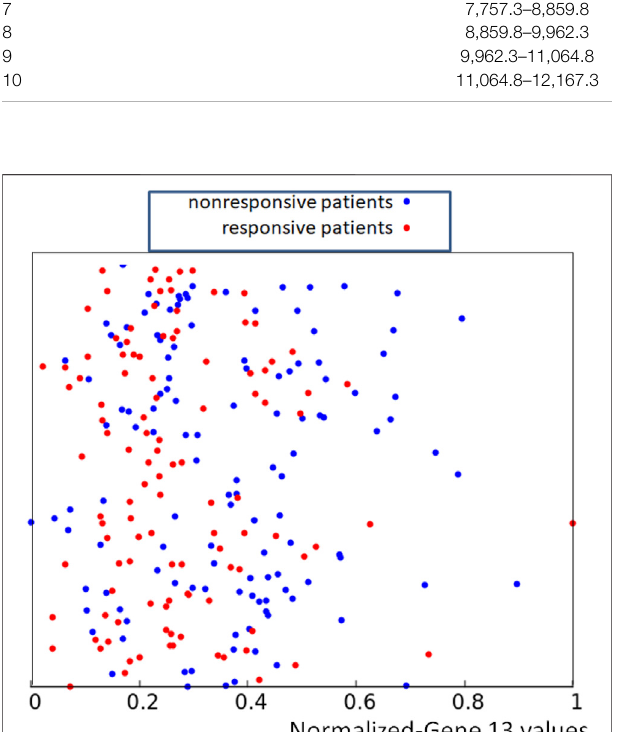
FIGURE 2 | The distribution of normalized values of the RPS7 gene expression corresponding to responsive (red) and nonresponsive (blue) results ofdrug therapyrespectively. Thevalues of p 13, k are represented bythe x-coordinate of marked points. The y-coordinate was randomly generated to differentiate points.